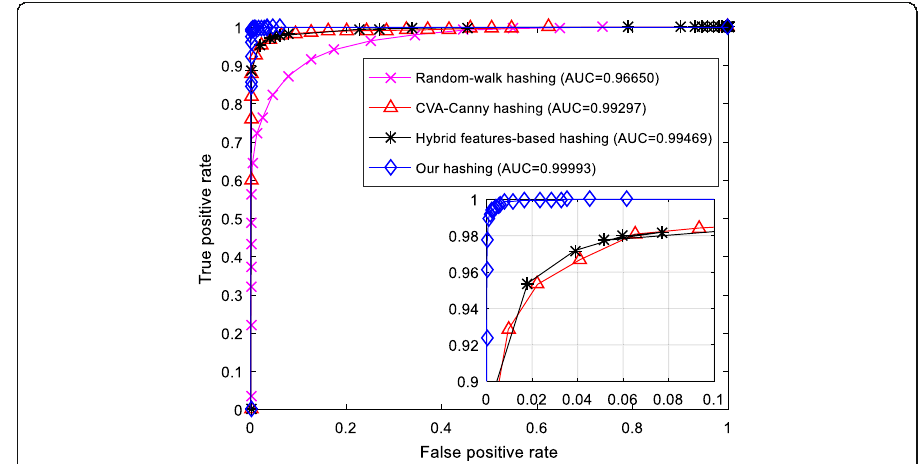
Fig. 11 ROC curve comparisons among different algorithms